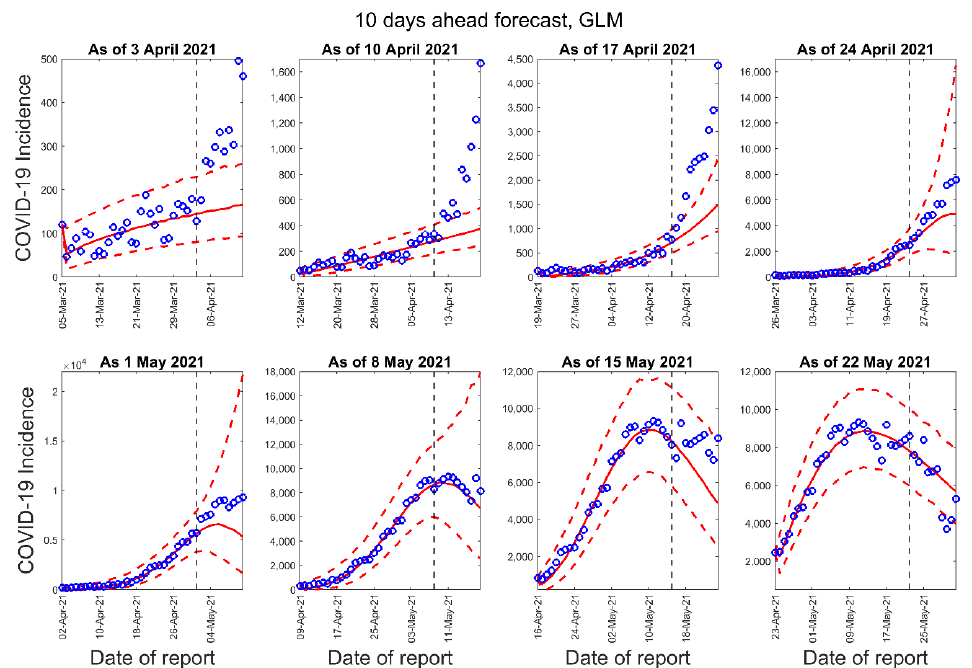
Figure 3. Ten-days ahead forecasts of the COVID-19 epidemic curves in Nepal by calibrating the GLM model for eight different periods. Blue circles correspond to the data points; the solid red line indicates the best model fit, and the red dashed lines represent the 95% prediction interval. The vertical black dashed line represents the time of the start of the forecast period.